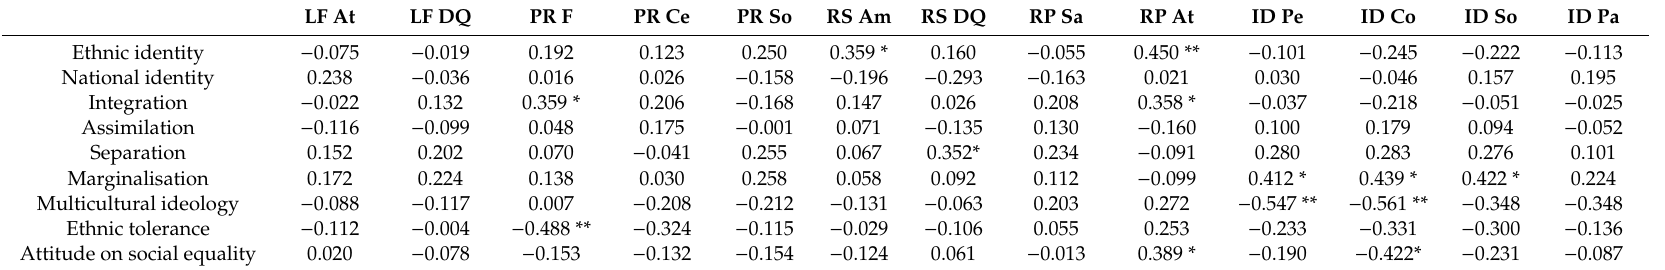
Table 6. The association of acculturation with beliefs of domains of CIYCFP ( n =